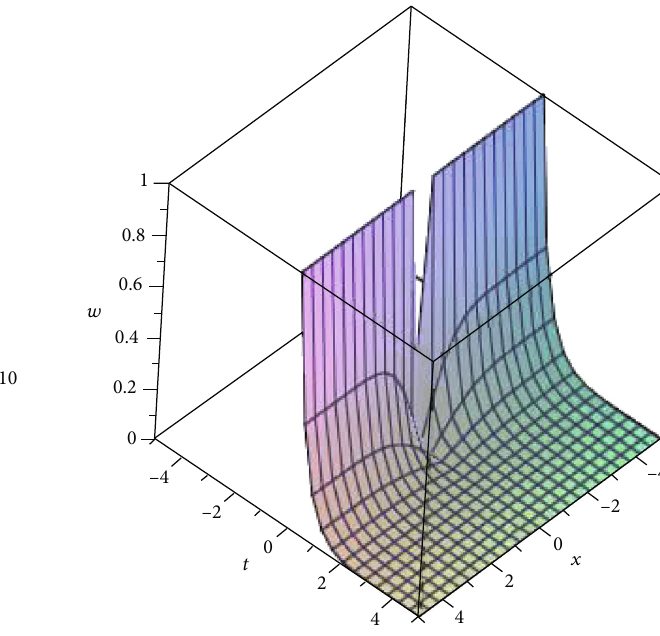
Figure 3: Sol. of (1) given by